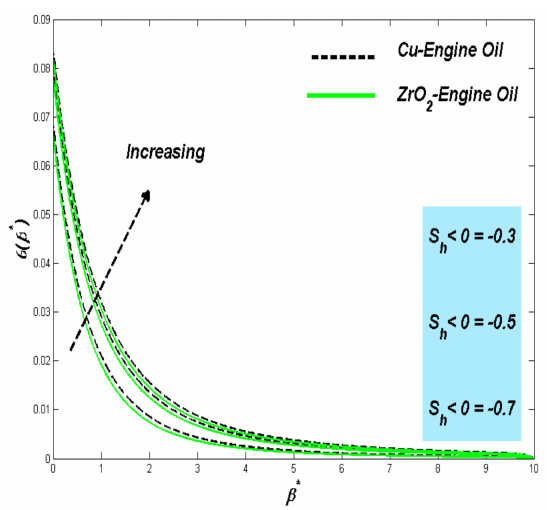
Figure 6. Temperature profile change with S h < 0.